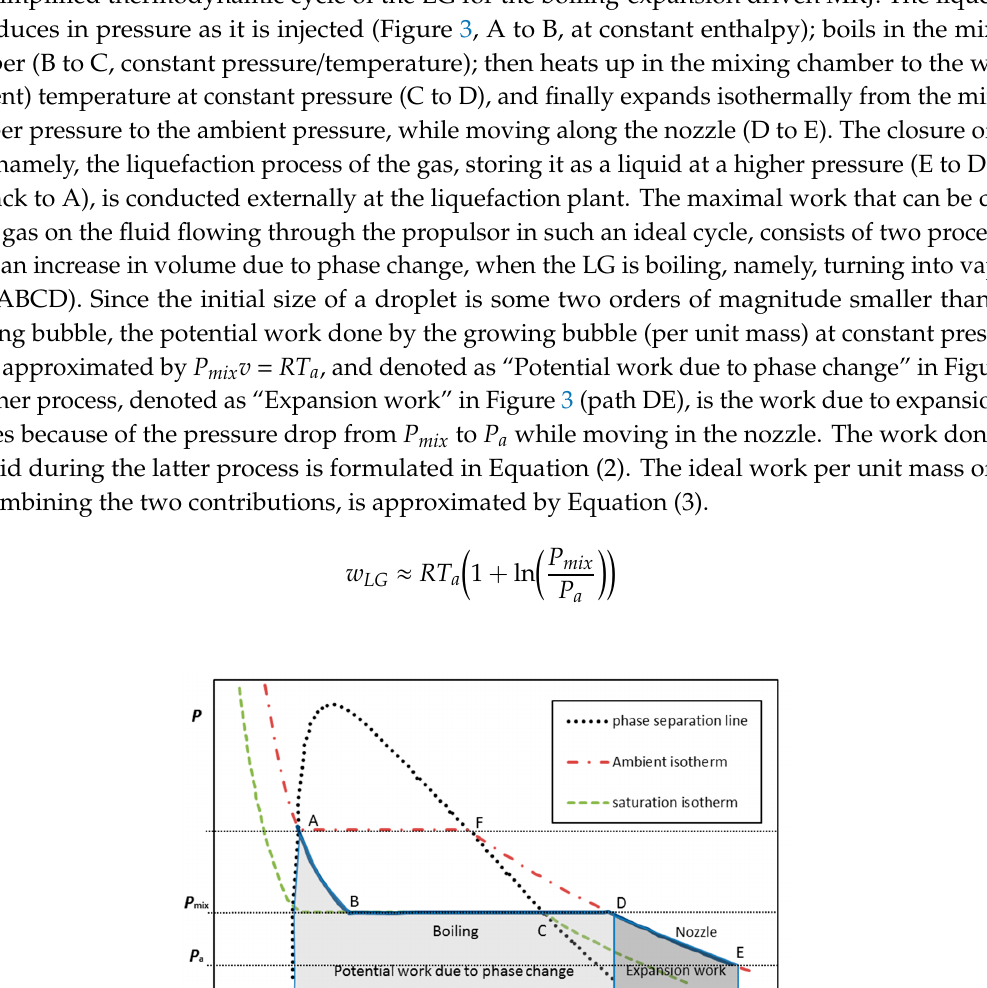
Figure 4. Phase change (boiling) of a 2 mm propane droplet while moving due to buoyancy within a column of water at ambient temperature and pressure (data adapted from Haustein et al. [31]).